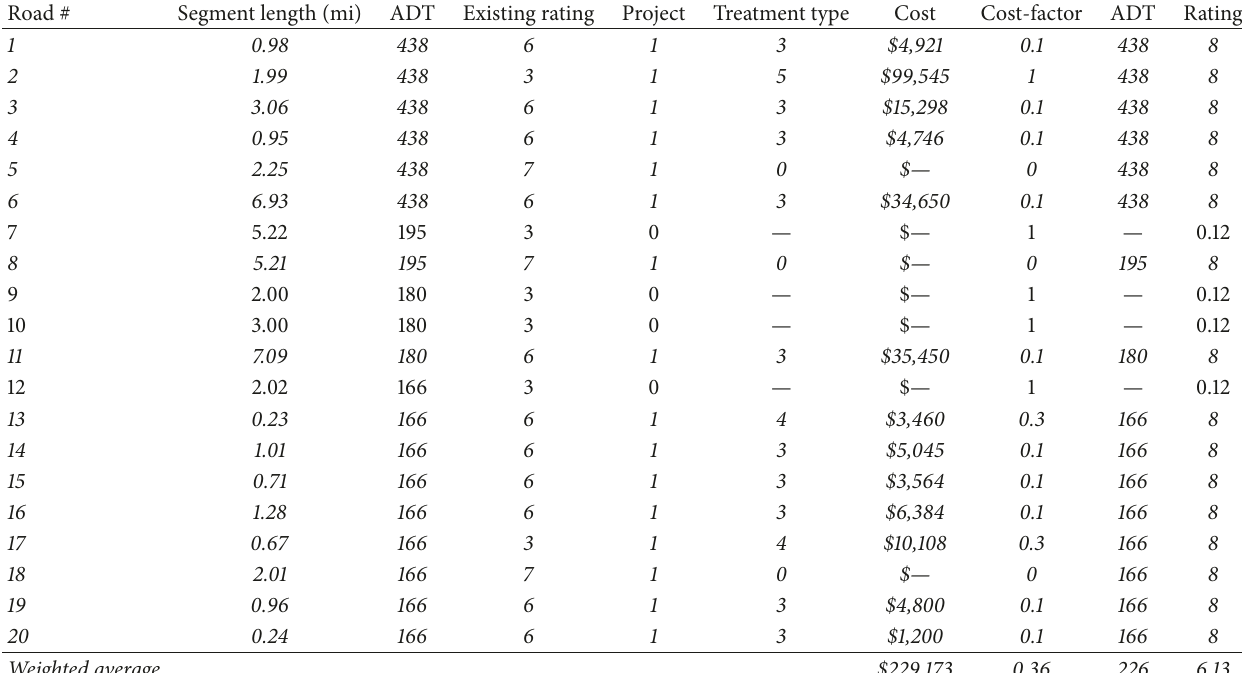
Table 7: Summary results optimizing the combination model in the first 3 months with a budget of $261 thousand.